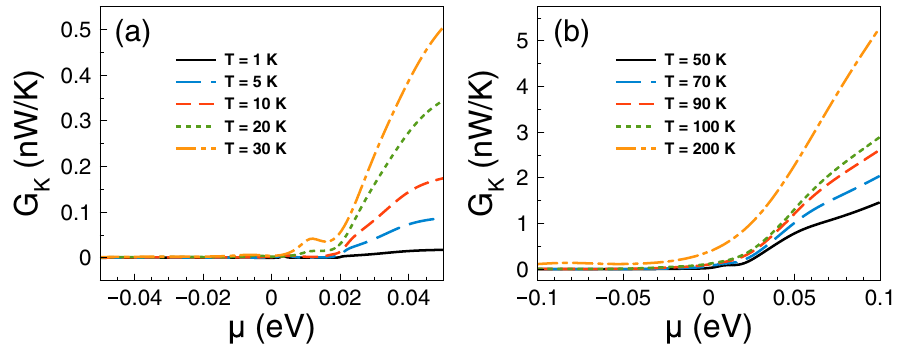
Figure 13. Electronic thermal conductance versus chemical potential for gapless bilayer graphene double barriers at different temperatures: ( a ) from 1 to 30 K and ( b ) from 50 to 200 K. The double barrier structural parameters are the same as in the preceding figures. Here, it is important to remark that G K /( GT ) is not the Lorenz number due to the nanostructuration effects. This results in a reduction of ZT about an order of magnitude with respect to strained single layer graphene 54 . The outcomes of G K /( GT ) and S in the supplementary information.